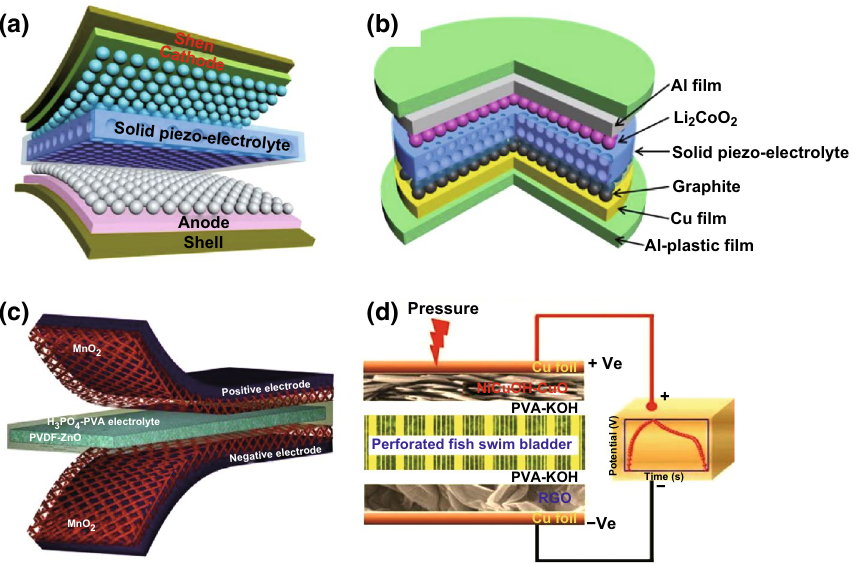
Fig. 4 Schematic diagram showing the design of all‑solid‑state SCPCs ( a ) and the design of a flexible SCPC ( b ). Al‑plastic film is used as the shells of flexible SCPCs. Reprinted with permission from Ref. [11]. c Schematic diagram of the fabricated SCSPC. MnO 2 on aluminum foil is used as the positive and negative electrodes and PVDF–ZnO film as a separator. Reprinted with permission from Ref. [17]. d The effect of mechanical deformation (by pressure) on the SCASC device. Reprinted with permission from Ref.